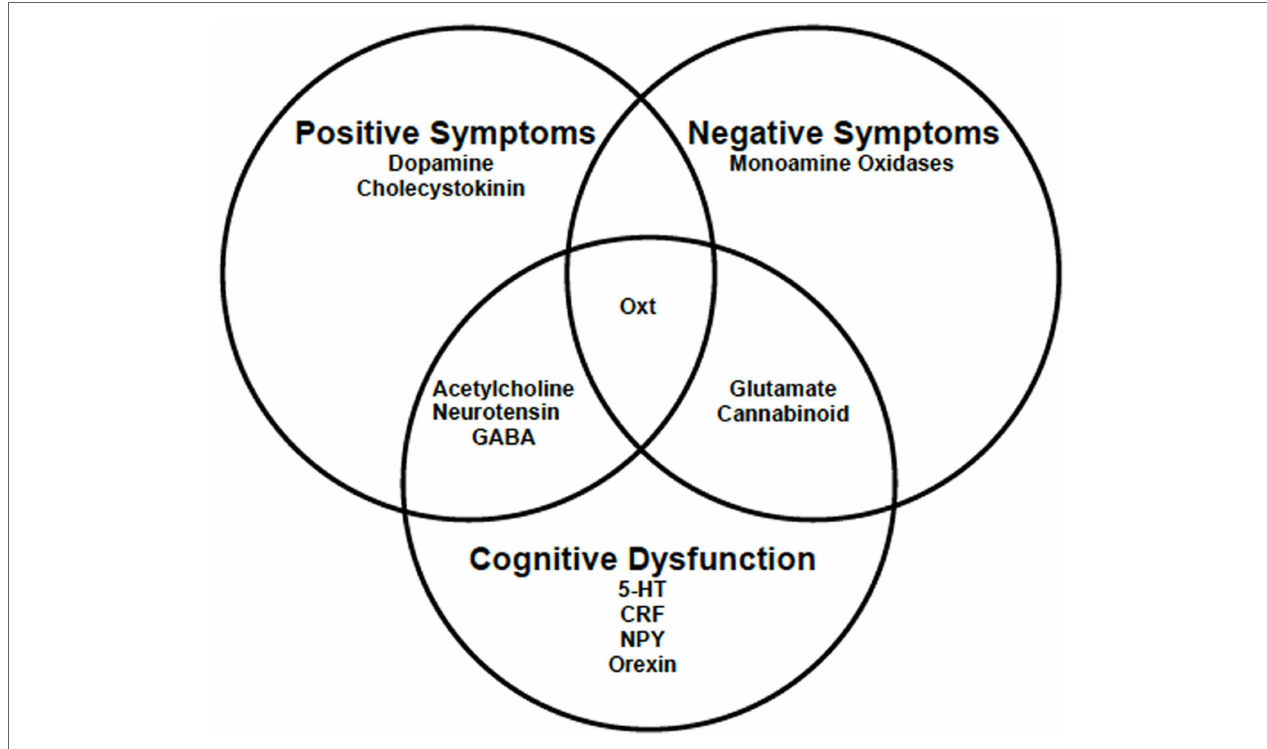
associated with schizophrenia. 5-HT, serotonin; CRF, corticotropin-releasing factor; GABA, gamma aminobutyric acid; NPY, neuropeptide y; Oxt,